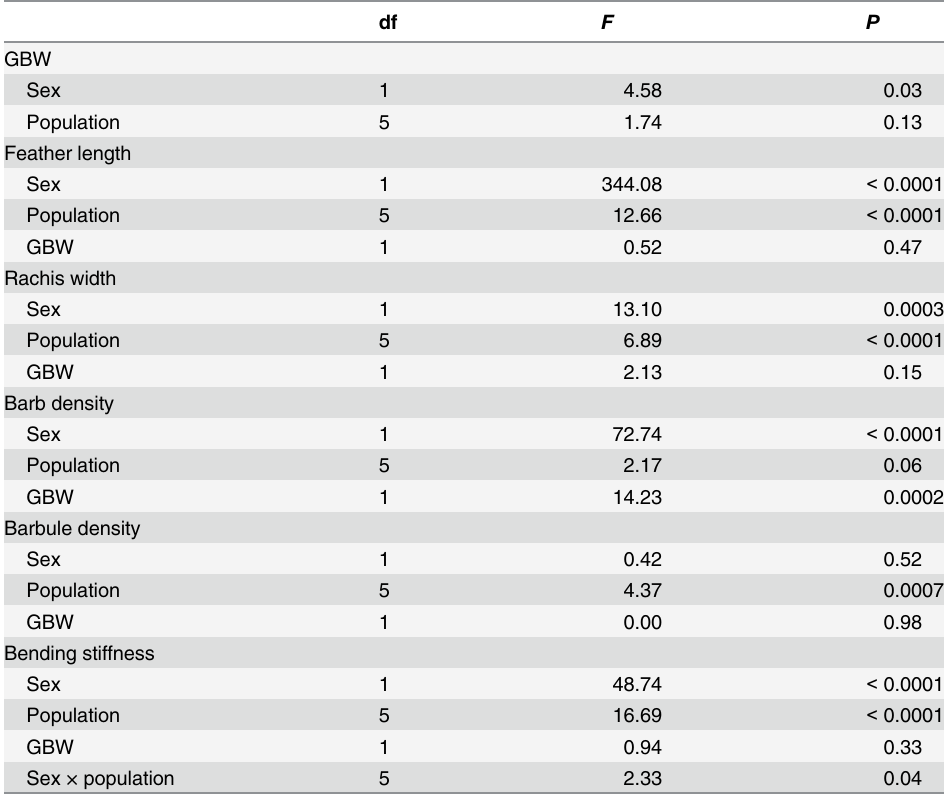
Table 4. Linear models of the relationship between quality traits and GBW of the outermost tail feather (Ta6) of male and female barn swallows from six European populations. df F P